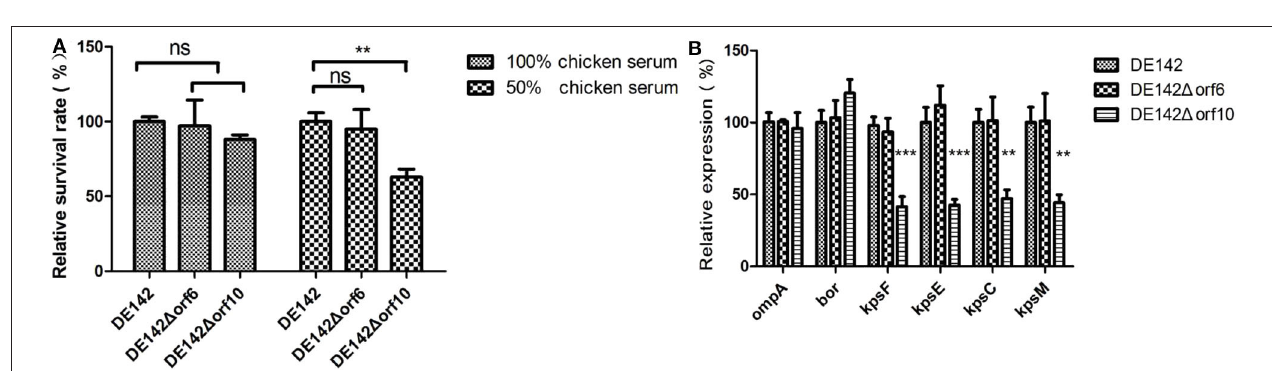
FIGURE 3 | Competition assays. (A) The competition between WT and DE142 1 orf6 . (B) The competition between WT and DE142 1 orf6 / orf6 *. Each derivative strain was mixed with the wild-type strain DE142A at a concentration ratio of 1:1. After incubation at 37 ◦ C for 3h, the number of each strain was estimated by counting on LB plates with ampicillin (WT) or chloramphenicol (derivative strains). The competition index (CI) represented the final relative numbers of the derivative strain compared to the wild-type strain DE142A. The Mann-Whitney U- test was performed for significance, *** P < 0.001.